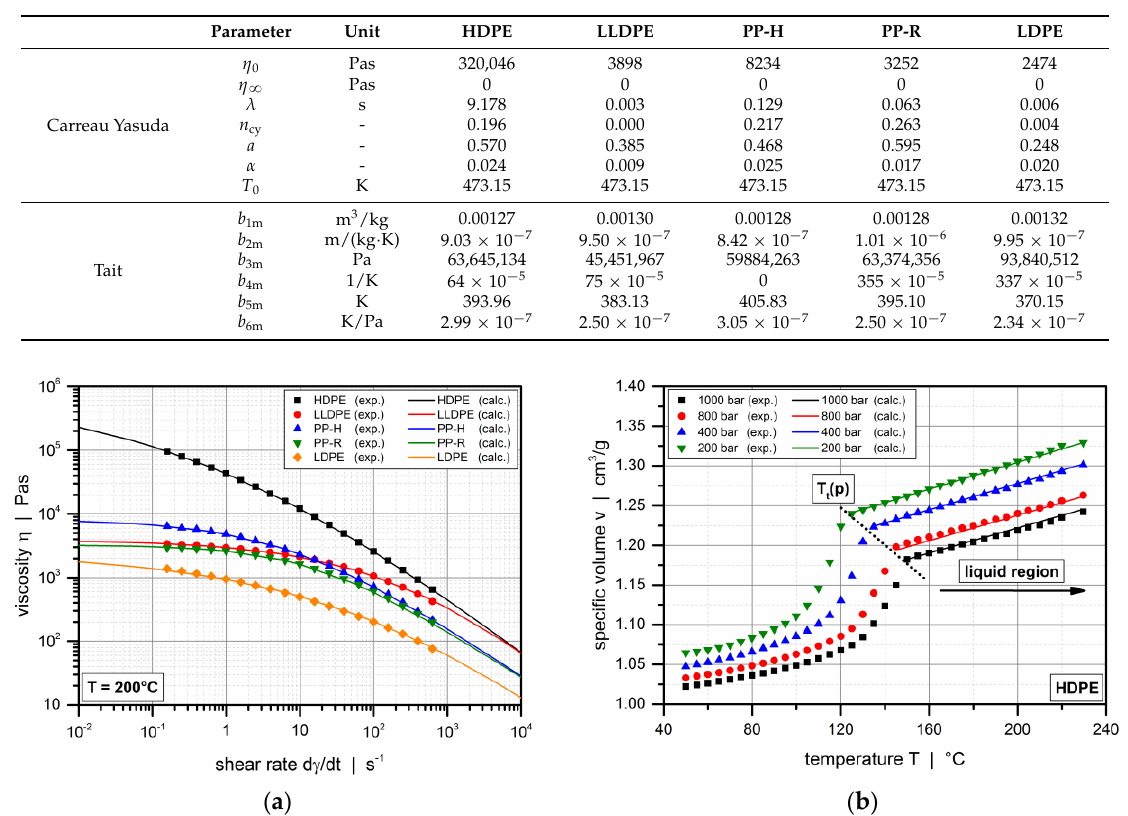
Table 3. Carreau-Yasuda and Tait model parameter values.